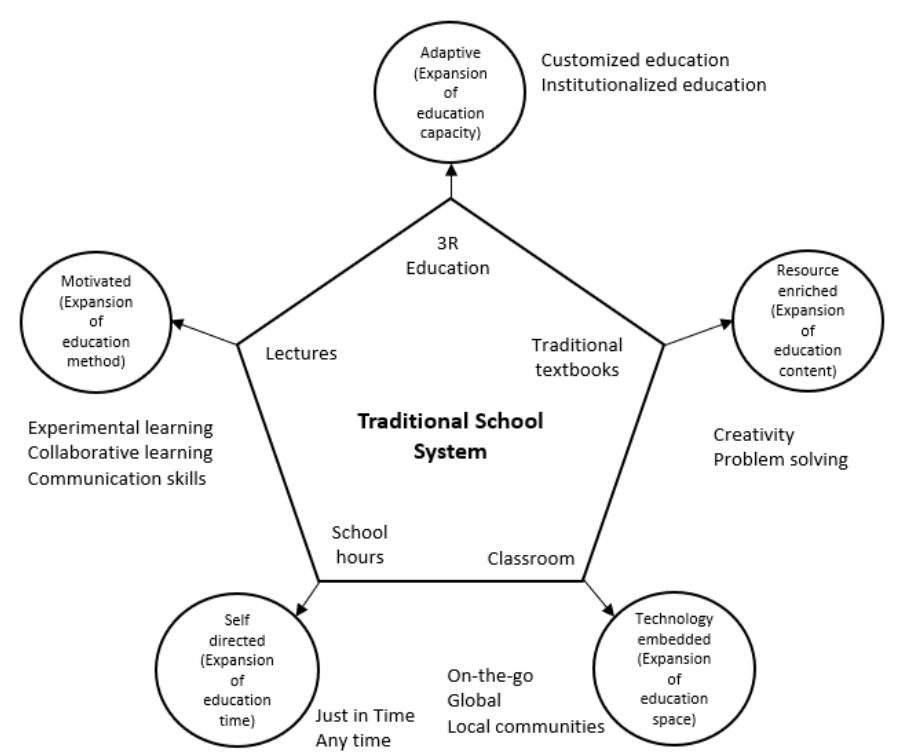
Figure 1. S mart learning concepts based on [37]. Figure 1. Smart learning concepts based on